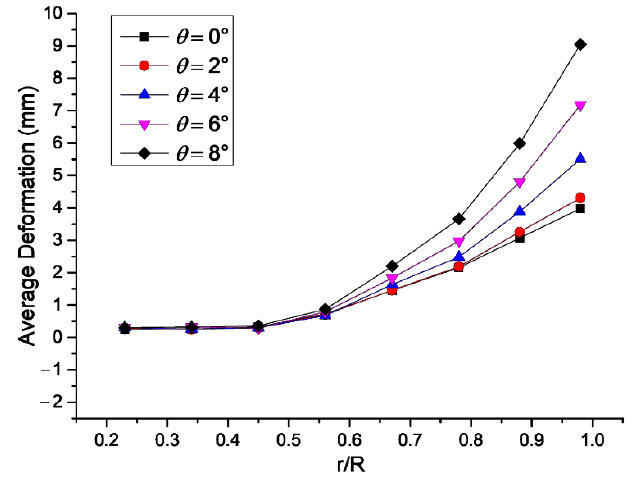
Figure 15. Average deformations at eight radial locations with five collective pitch angles.